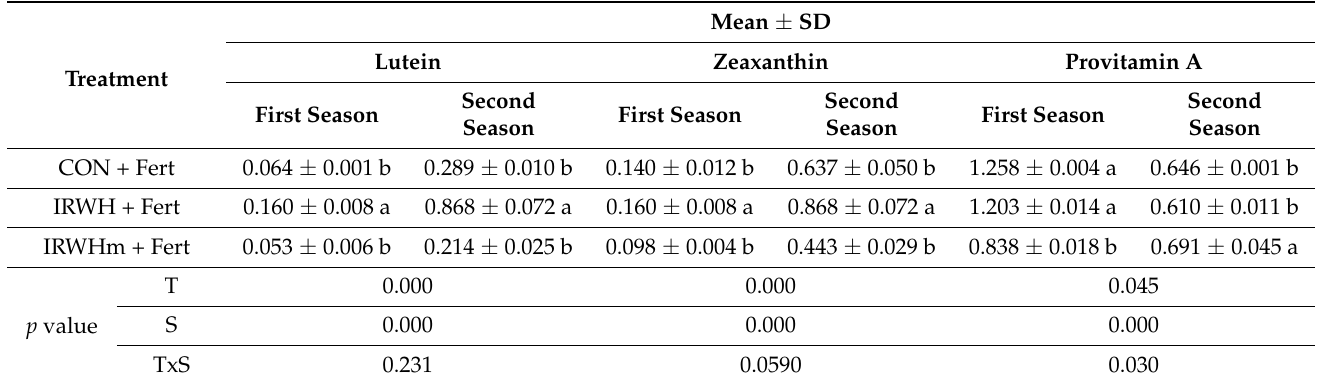
Table 7. The effect of season, agronomic treatment and water-use technology on the